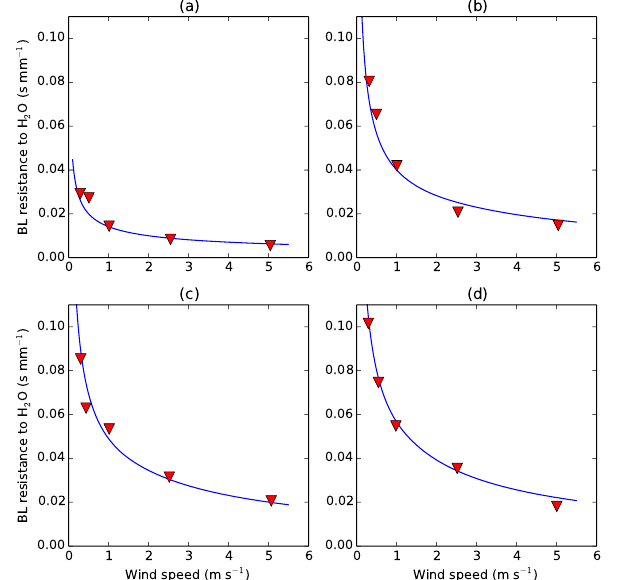
Figure 2. Modelled leaf boundary layer resistance compared to ob- servations by Dixon and Grace (1984). Lines represent inverse of boundary layer conductance (Eqs. A1, A4 and A7), converted to the same units as in Dixon and Grace (1984). Characteristic length scales of leaves ( L l ) are chosen to achieve closest match with dots extracted from Fig. 1 in Dixon and Grace (1984). (a) P. sylvestris ( L l = 0 . 0025m); (b) S. aucuparia ( L l = 0 . 02m); (c) Q. robur ( L l = 0 . 03m); (d) F. sylvatica ( L l = 0 .